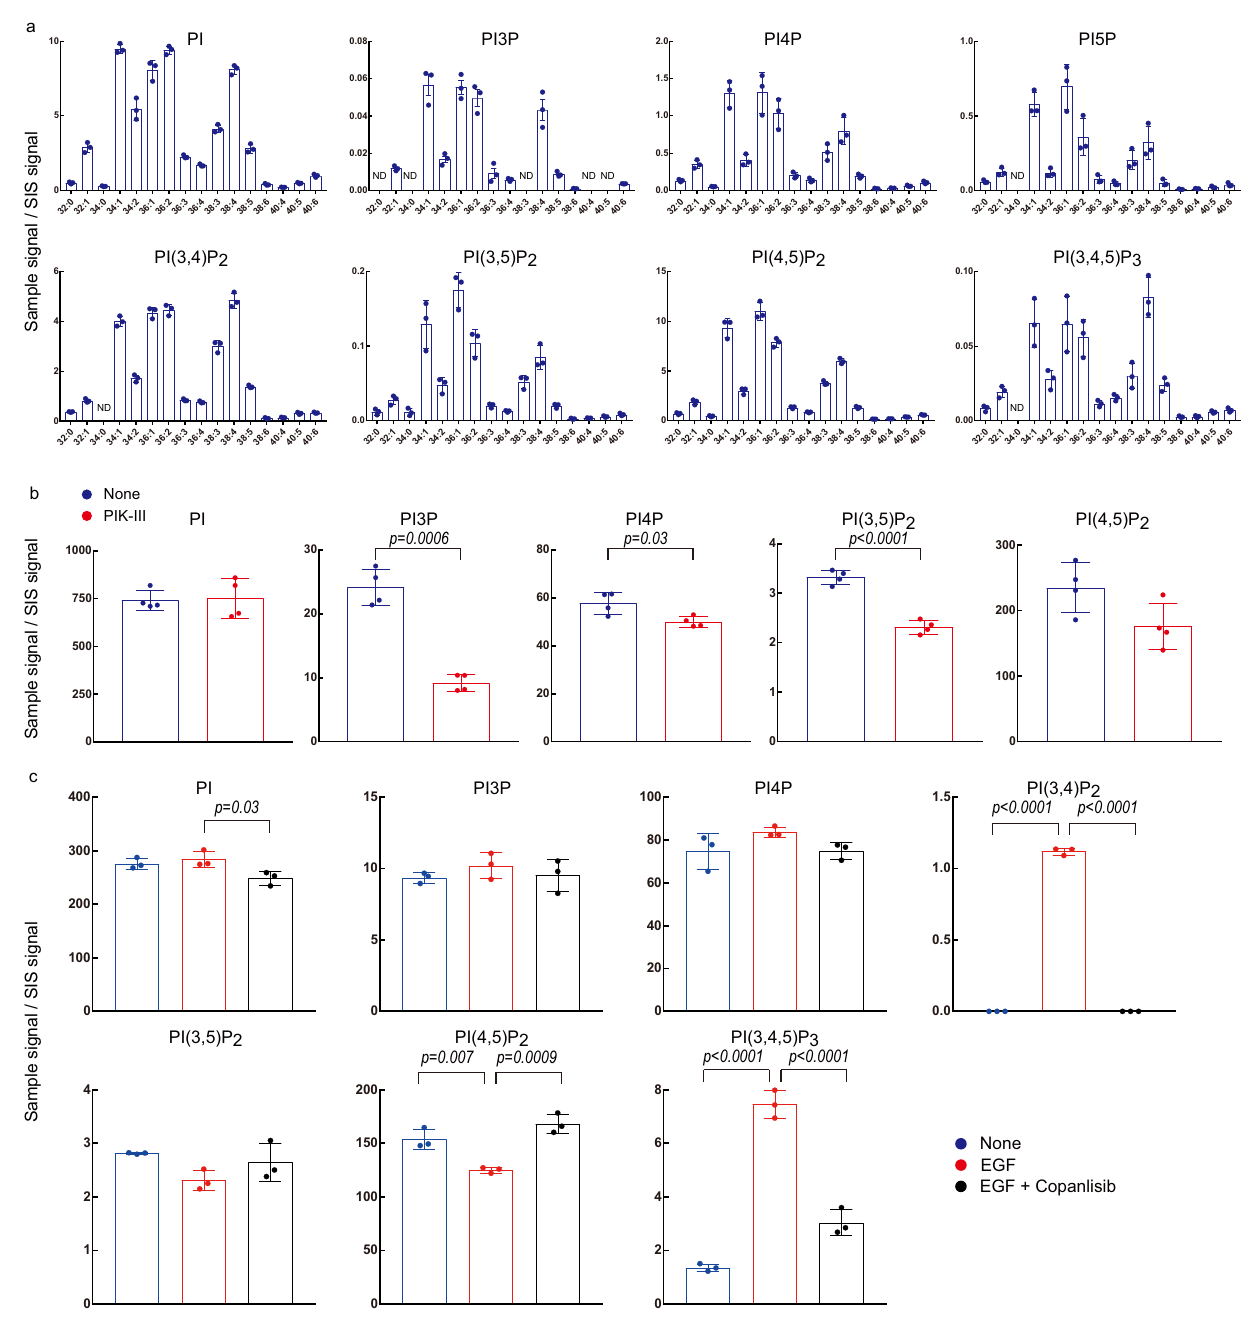
Fig. 2 Application of PRMC-MS to phosphoinositide measurement in cell lines. a Levels of the indicated phosphoinositide acyl variants in HEK293T cells. PI, PI3P, PI4P, PI(3,5)P 2 , PI(4,5)P 2 , and PI(3,4,5)P 3 were assessed in mock-transfected cells. PI5P was assessed in cells overexpressing IpgD. PI(3,4)P 2 was assessed in non-transfected cells treated with 1 mM H 2 O 2 for 5 min. Data were the mean ± SD ( n = 3 biologically independent samples). ND not determined. b Phosphoinositide measurements in HeLa cells treated with vehicle (control) or 5 µ M PIK-III for 2 h. PI5P, PI(3,4)P 2 , and PI(3,4,5)P 3 were not detected. Data were the mean ± SD of total acyl variants of the indicated phosphoinositide classes ( n = 4 biologically independent samples), and p values by two-sided Welch ’ s t -test are shown. c Phosphoinositide measurements in PC3 cells that were left untreated (control), or treated with vehicle or 100 nM copanlisib for 30 min prior to stimulation with 10 ng/ml EGF. PI5P was not detected. Data were the mean ± SD of total acyl variants of the indicated phosphoinositide classes ( n = 3 biologically independent samples). The signi fi cance was analyzed using a two-sided Dunnett ’ s t -test. Source data are provided as a Source Data fi HEK293T cells overexpressing various mutant PIK3CA proteins. PIK3CA gain-of-function mutations frequently occur at two hotspots: one in the helical domain (E545K) and one in the kinase determine the effect of oncogenic phosphoinositide 3-kinase domain (H1047R) 4 . We found that ectopic expression of these expression on extracellular phosphoinositides, we examined mutant PIK3CA molecules caused enormous increases in